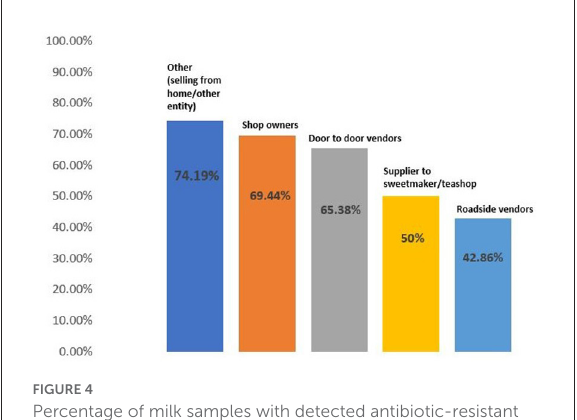
FIGURE4 Percentage of milk samples with detected antibiotic-resistant bacteria out of the total milk samples collected from different milk vendor categories in Assam and Haryana,